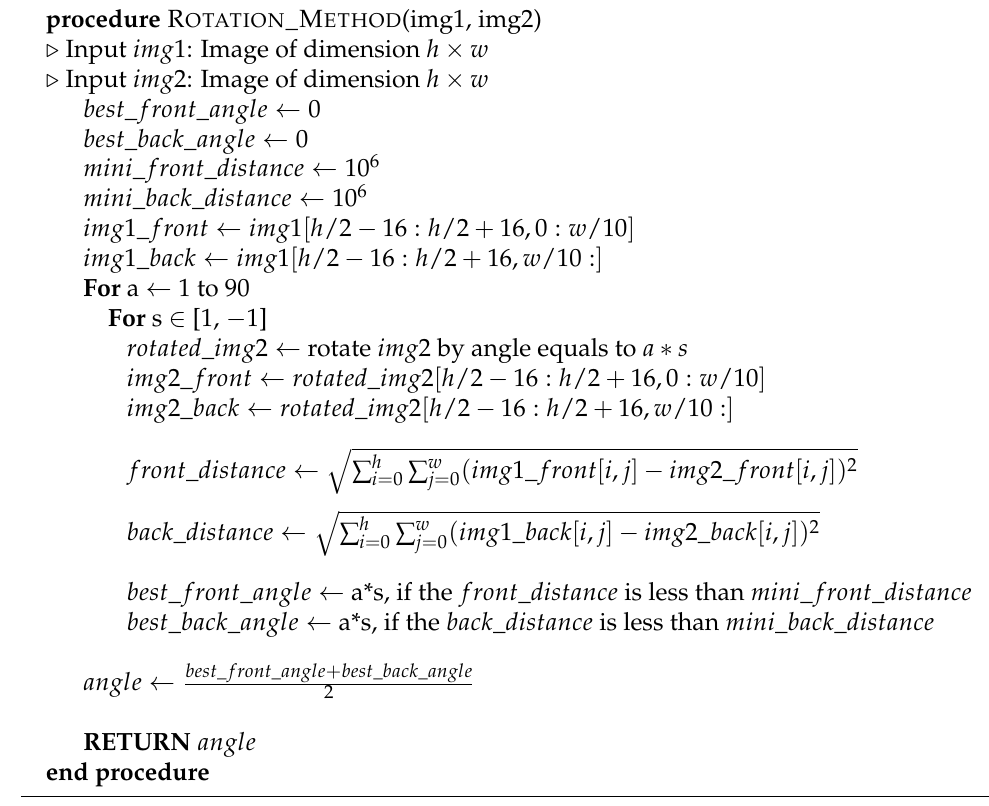
Algorithm 3 Rotation method